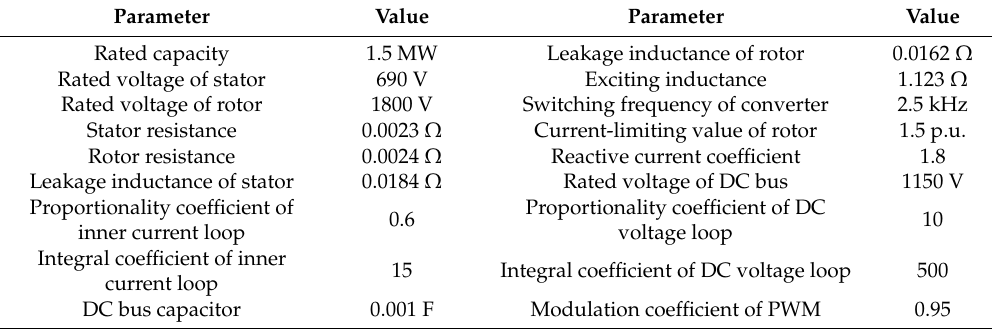
Table 3. Parameters of the tested DFIG-WT.